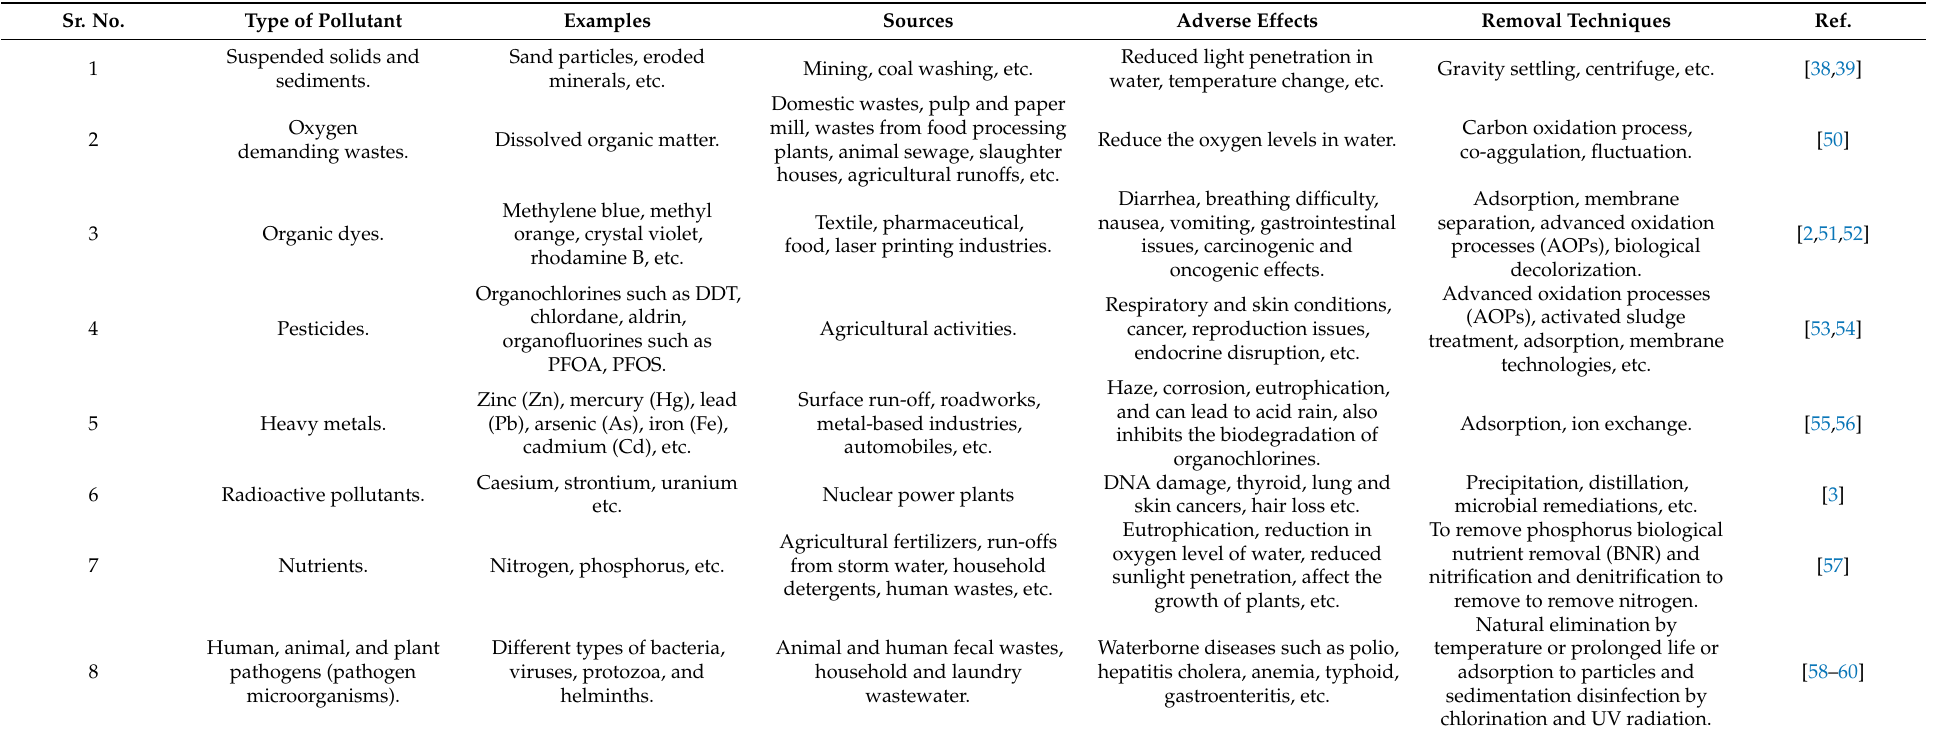
Table 1. Pollutants, their sources, adverse effects, and removal